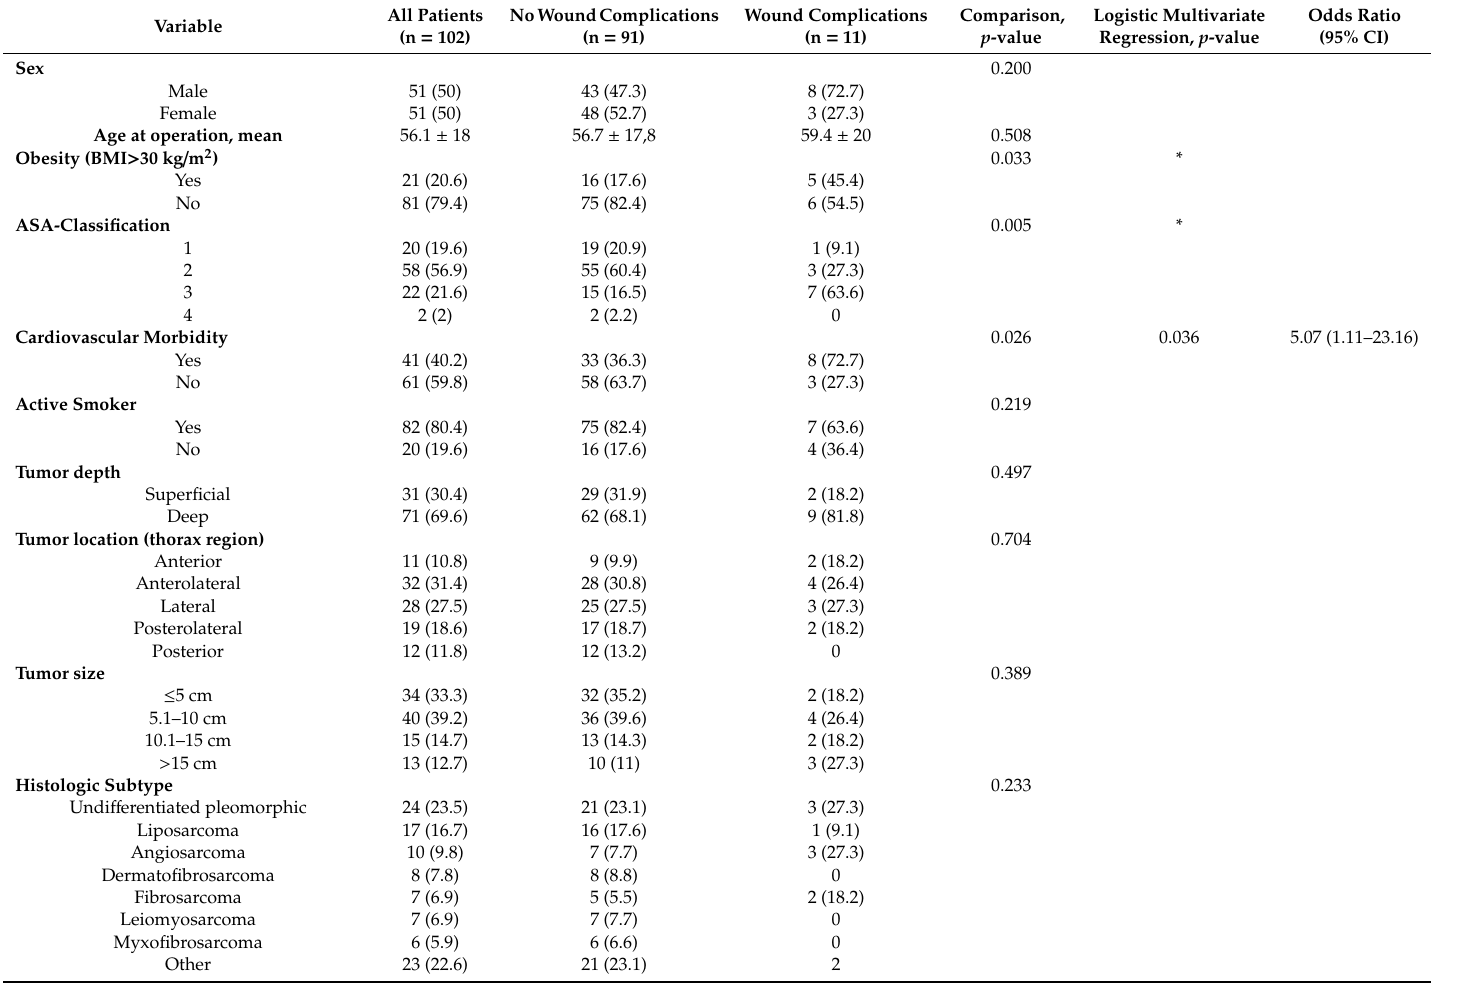
Table 2. Population and comparison of groups with and without wound